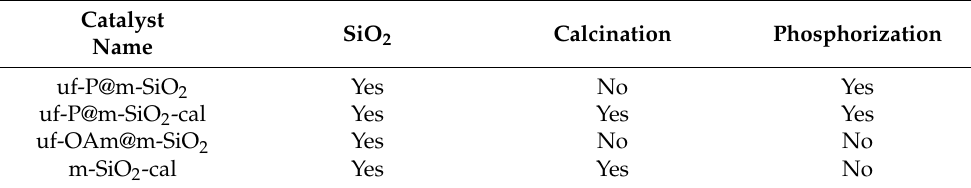
Table 1. Catalyst preparation steps based on the synthesis procedures